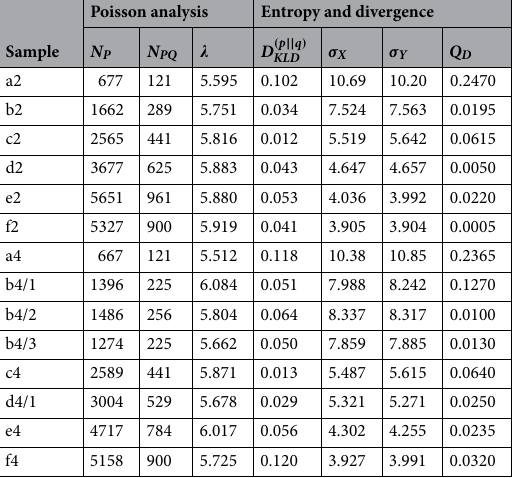
Table 2. Detailed analysis of samples under